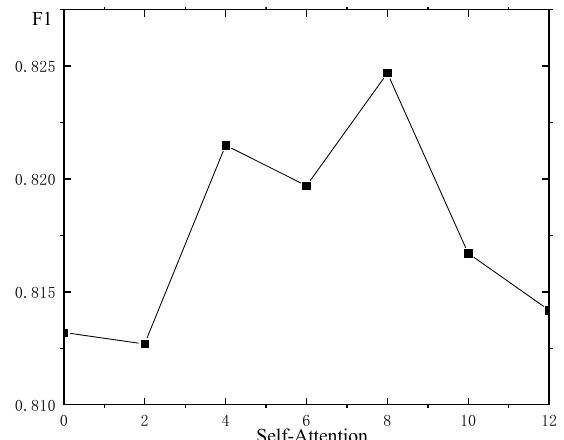
Figure 6. Experimental results with different levels of self-attention.